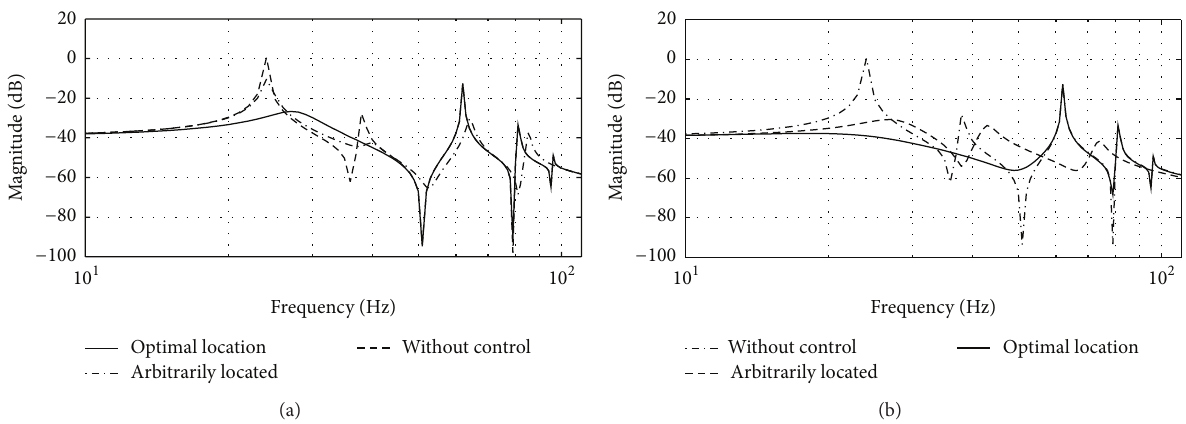
Figure 4: Frequency response of the plate controlled by the piezoelectric actuator-sensor patches when the first two modes are controlled, while the next three modes are the residual modes: (a) one actuator-sensor and (b) a pair of actuator-sensors. Table 3: Material properties of piezoelectric transducers made of PZT-5H from [28].